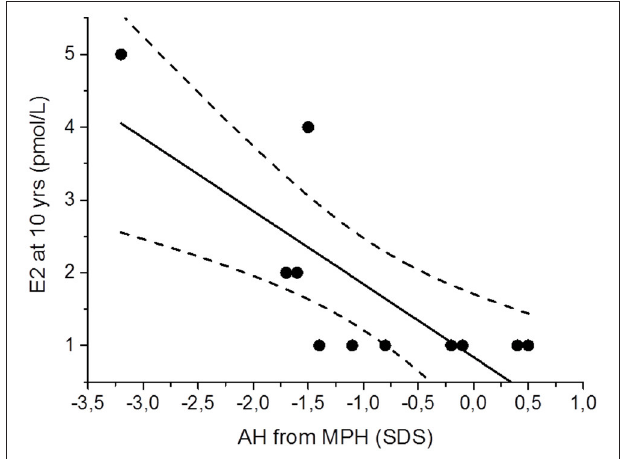
FIGURE 2 | Scatter plot presenting the association between serum estradiol (E2) concentrations at 10 years (yrs) and adult height (AH) adjusted for mid parental height (MPH) in 11 males with Silver-Russell Syndrome. Linear regression analysis (95% confidence bands as dashed lines) yielded a strong negatively correlation: r = − 0.78, p <